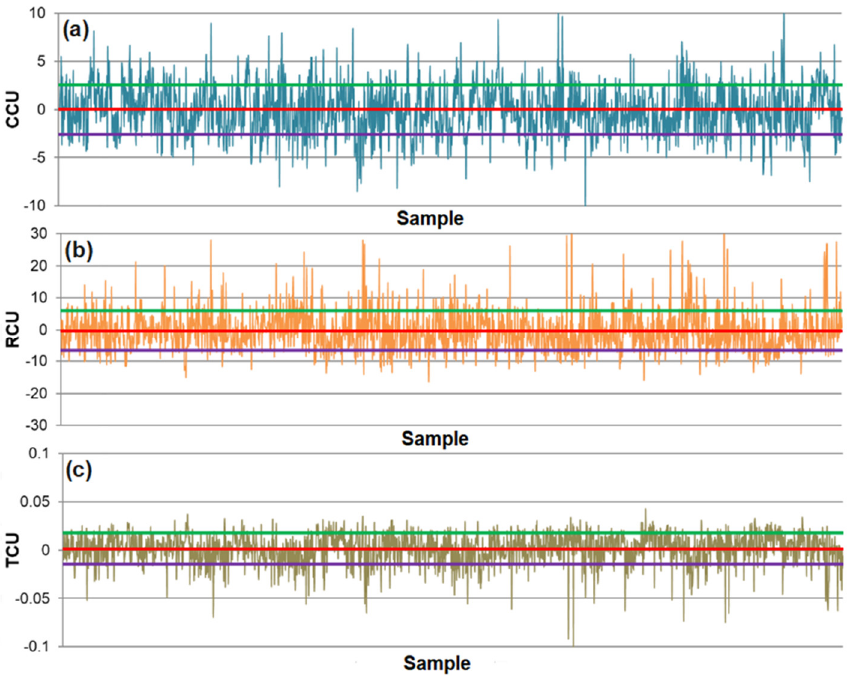
Figure 22. Prediction errors of technological indicators according to the ( a ) NN1, ( b ) NN2 and ( c ) NN3 models. The red line on the charts represents mean (μ), green line value μ + 1 SDE and purple line value μ − 1 SDE.